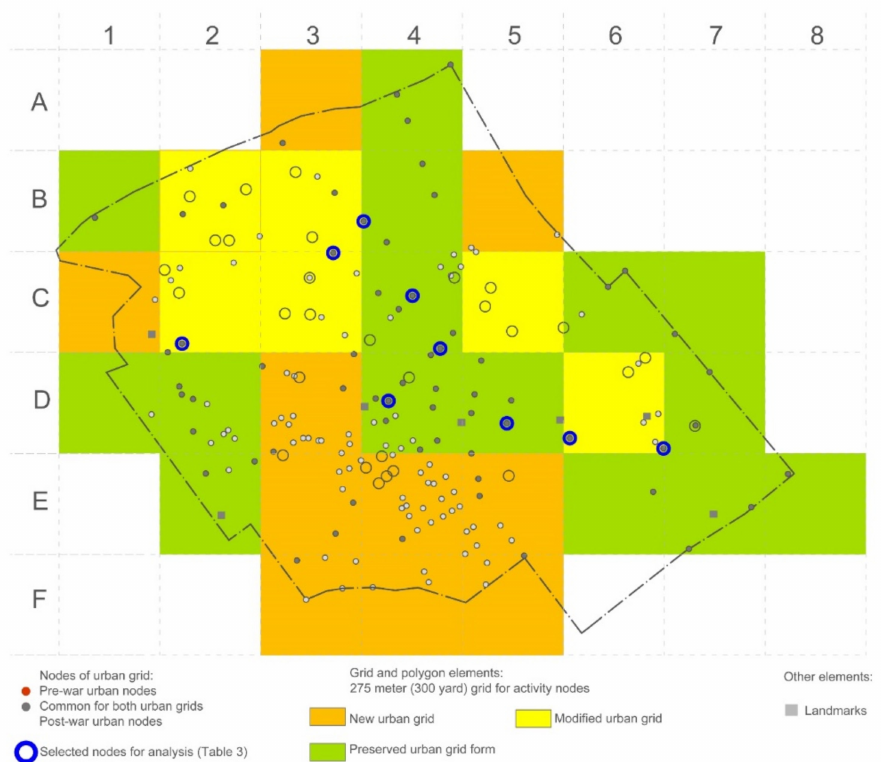
Figure 8. The reference of the distribution of nodal points to the polygon mesh. Indication of the areas of post-war interference in the urban tissue and selection of the location of points to be examined in the next stage of compositional analysis; prepared by M.